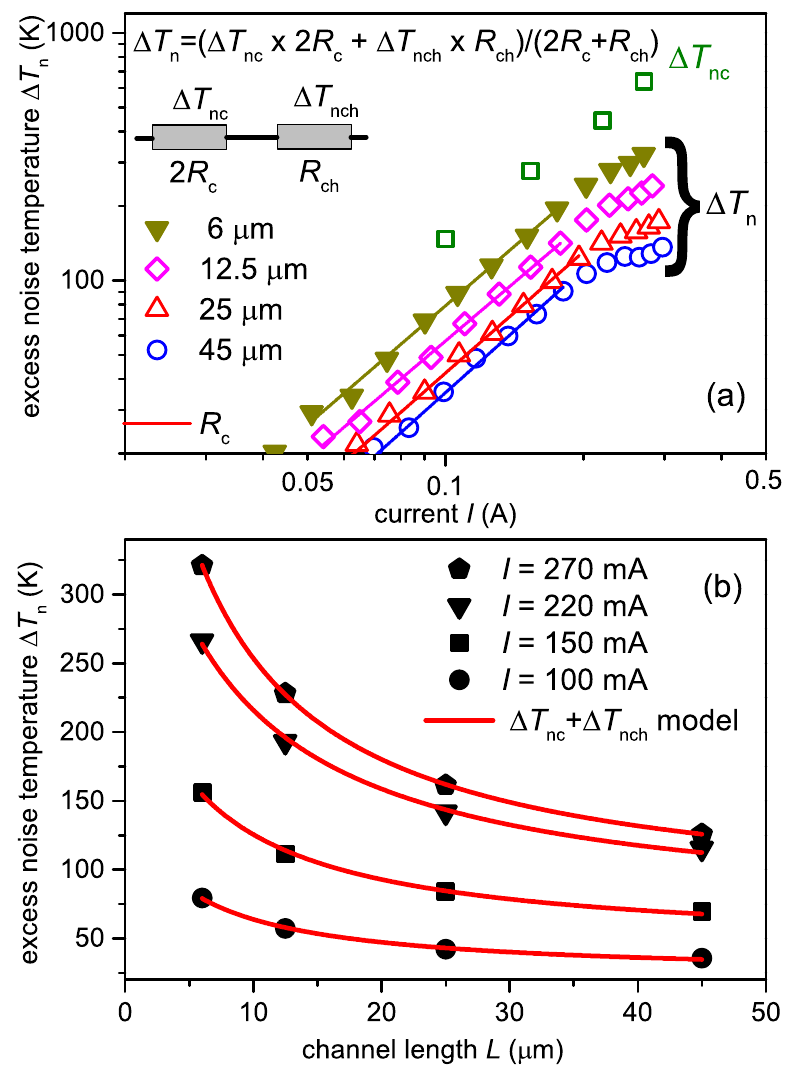
Figure 6. The dependence of the microwave excess noise temperature ∆ T n on the current for the different channels length of the same TLM in the AlGaN/GaN sample ( a ). L = 6 µ m (closed triangles), 12.5 µ m (open diamonds), 25 µ m (open triangles) and 45 µ m (open circles). Lines guide the eyes. Estimated ∆ T n at the constant currents is plotted versus channel length ( b ). I = 100 mA (circles), 150 mA (rectangles), 220 mA (triangles) and 270 mA (pentagons). Curves are the fit by the model (Equation (6)). Excess noise temperature ∆ T nc of the contact resistance R c is estimated as a fitting parameter and its current dependence is depicted by the open